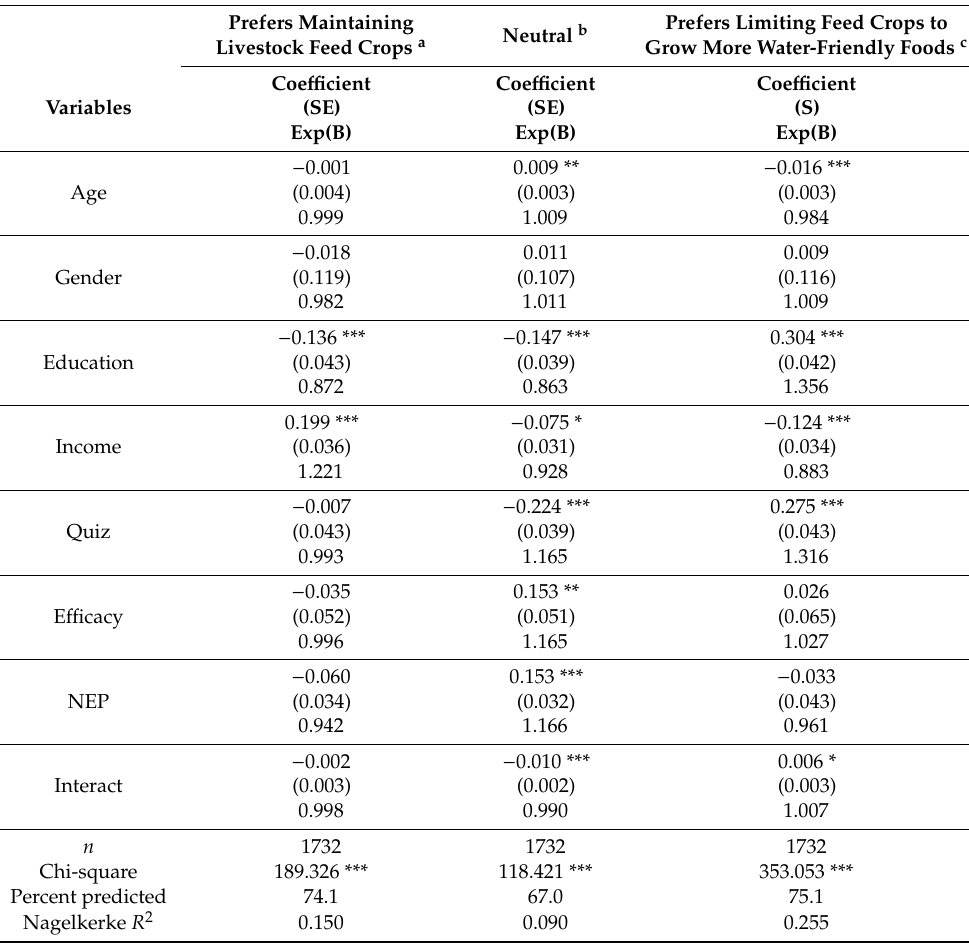
Table 5. Logistic regression estimates for the agricultural tradeo ff